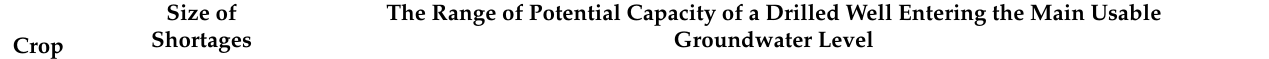
Table 4. Percentage of the area of crops potentially affected by water shortages, with a proba- bility of 50% in the area of groundwater resources in the distinguished performance ranges of a drilled well [%].